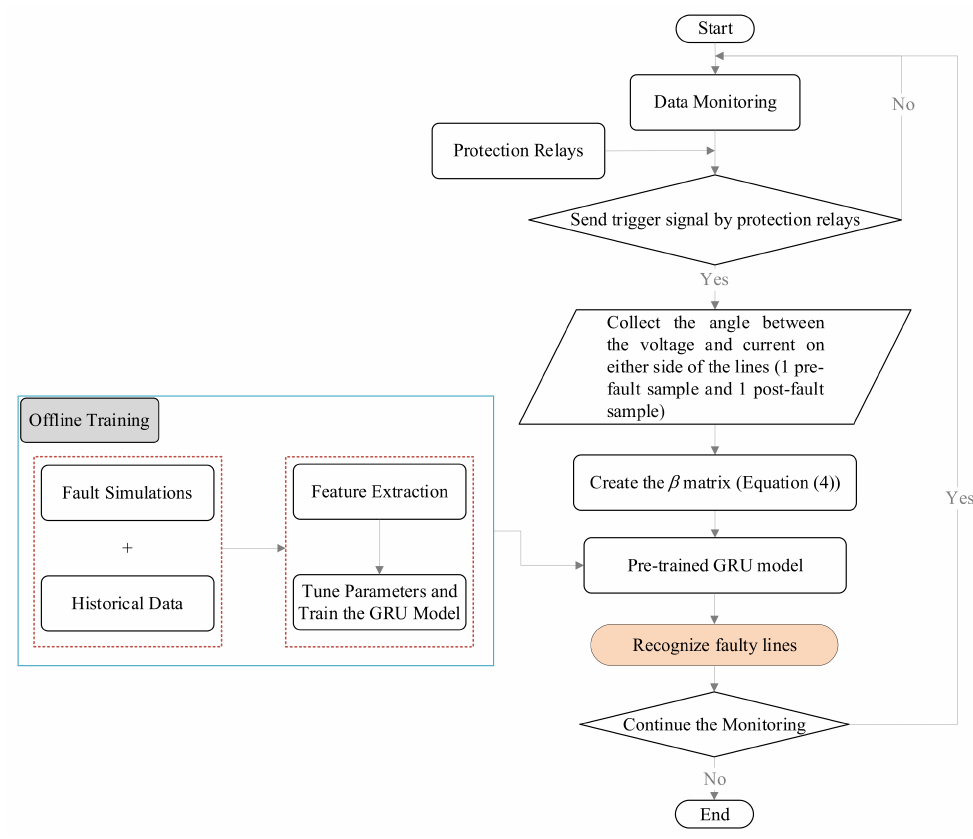
Figure 5. The proposed framework to recognize the faulty